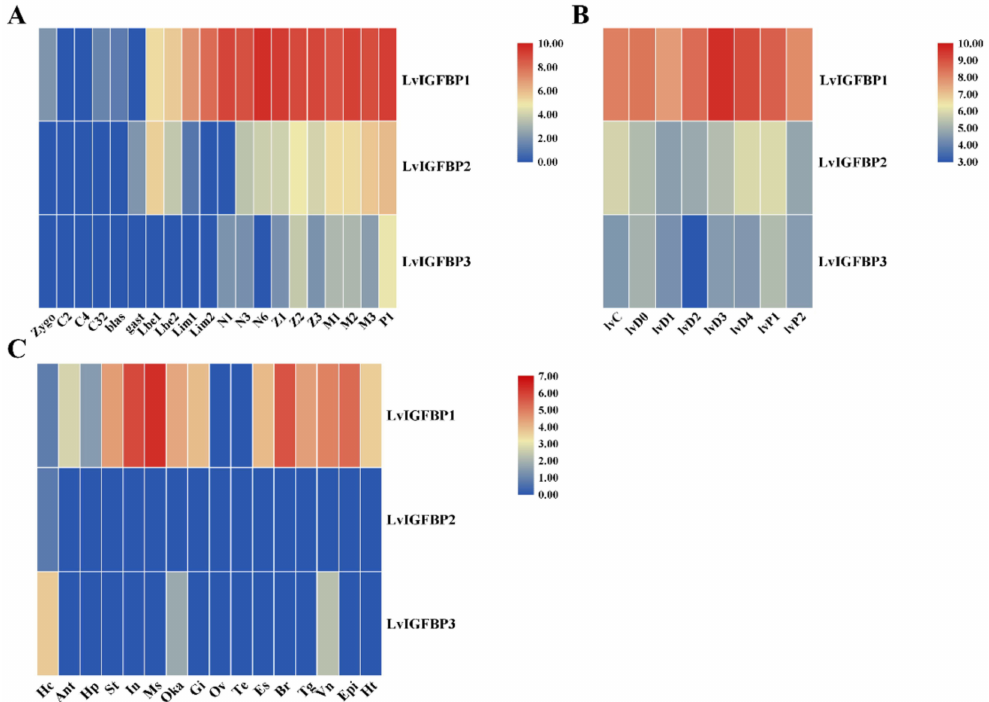
Figure 4. Heatmap of LvIGFBP gene expression profiles in ( A ) early development stages: zygote (zygo), 2 cell (C2), 4 cell (C4), 32 cell (C32), blastula (blas), gastrula (gast), limb bud embryo I (Lbe1), limb bud embryo II (Lbe2), larva in membrane I (Lim1), larva in membrane II (Lim1), nauplius I (N1), nauplius III (N3), nauplius VI (N6), zoea I (Z1), zoea II (Z2), zoea III (Z3), mysis I (M1), mysis II (M2), mysis III (M3), and postlarvae 1 (P1); ( B ) molting stages: the inter-molt (C), pre-molt (D0, D1, D2, D3, and D4), and post-molt (P1 and P2) stages; and ( C ) adult tissues: hemocyte (Hc), antenna (Ant), muscle (Ms), intestines (In), ovary (Ov), stomach (St), lymphoid organ (Oka), gill (Gi), hepatopancreas (Hp), testis (Te), eye-stalk (Es), brain (Br), thoracic ganglion (Tg), ventral nerve (Vn), epidermis (Epi), and heart